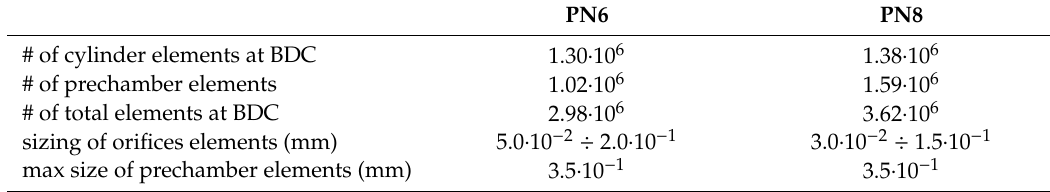
Figure 4. ( a ) Side view of the mesh of the fluid domain, including PN6 prechamber; ( b ) top view. Table 5. Details of the mesh used for the PN6 and PN8 prechambers. Table 5. Details of the mesh used for the PN6 and PN8 prechambers.